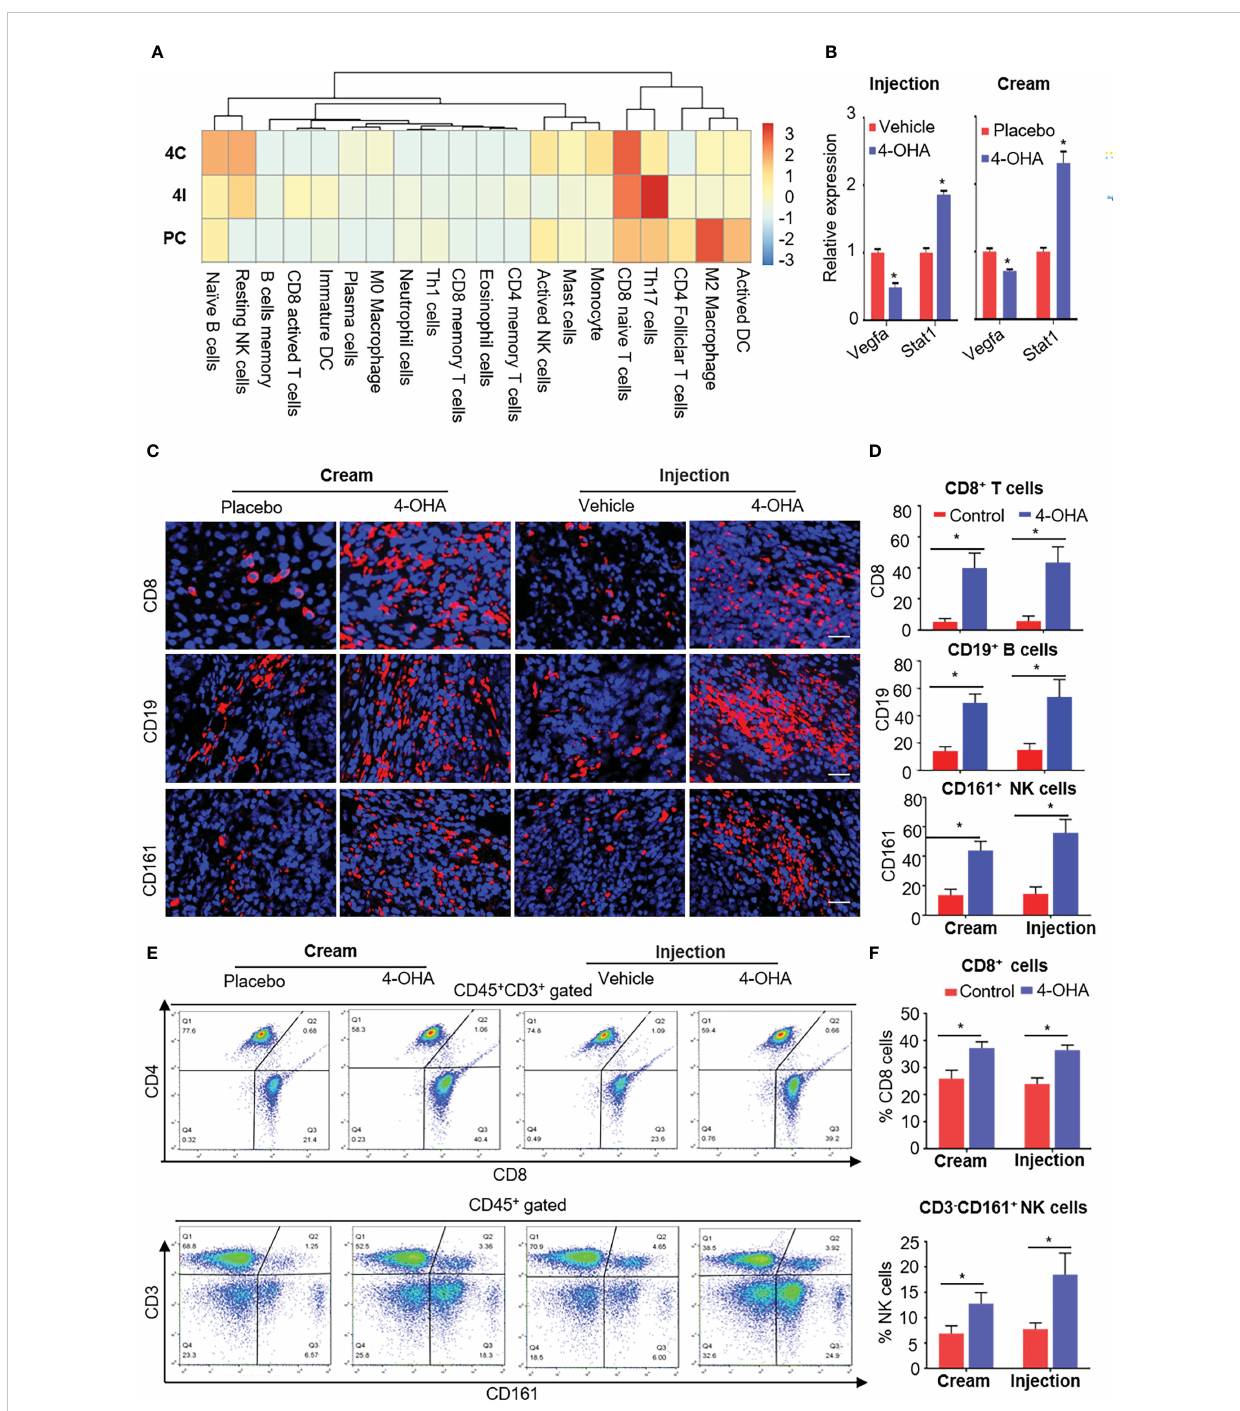
FIGURE 6 4-OHA treatment remodeled the tumor immune microenvironment. Female SD rats with at least one tumor reaching a size of 1.5 cm in diameter received vehicle peanut oil, placebo cream, 4-OHA cream, or 4-OHA injection for 4 weeks, as indicated in the Materials and Methods. (A) Heatmap of relative in fi ltrations of immune-cell populations in tumor tissues. (B) Expression levels of immune-related genes. (C) Representative images of tumors stained for CD8, CD19, or CD16/CD56. DAPI (nuclei) was also shown with each antibody. Scale bar, 20 m m. (D) Percentage of CD8, CD19, or CD161 positive cells. Counts were quanti fi ed from fi ve representative high-powered fi elds from each sample. (E, F) Flow cytometric analysis of the number of CD45+CD3+CD8+ and CD3- CD161+ NK cells in the tumor tissues. E shows an exemplary gating, F gives an overview of the results versus WT. Data are represented as the mean ± SEM. bars, SEM. *p ≤ 0.05 vs. control. PC, Placebo cream; 4C, 4-OHA cream; VI, vehicle; 4I, 4-OHA